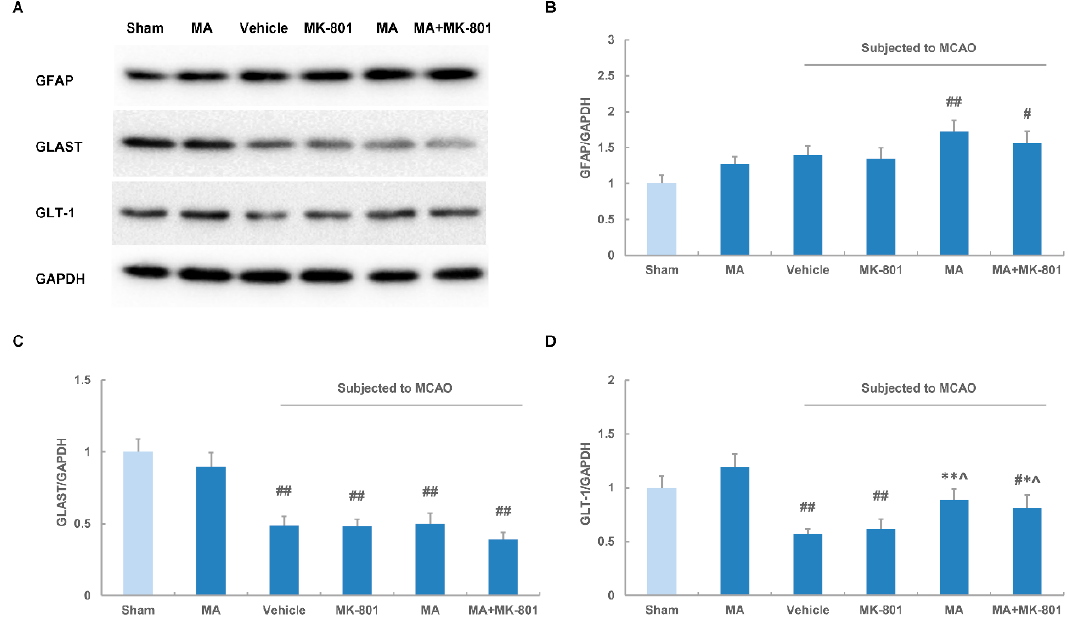
Figure 5. Maslinic acid up-regulates the levels of glial glutamate transporters after cerebral ischemia. ( A ) The immunoblots of GFAP, GLAST, GLT-1 and GAPDH were obtained by Western blot following 2 h of ischemia and 70 h of reperfusion. Maslinic acid (0.4 µ g/mL) was administered 15 min before MCAO. MK-801 (0.5 mg/kg) was given at 3 h after MCAO; Quantitative analysis of ( B ) GFAP; ( C ) GLAST; and ( D ) GLT-1 levels normalized to GAPDH. Data were expressed as means ± SEM from three independent animals. ## p < 0.01 versus the sham group; * p < 0.05, ** p < 0.01 versus the vehicle group; ^ p < 0.05 versus MK-801-treated group.